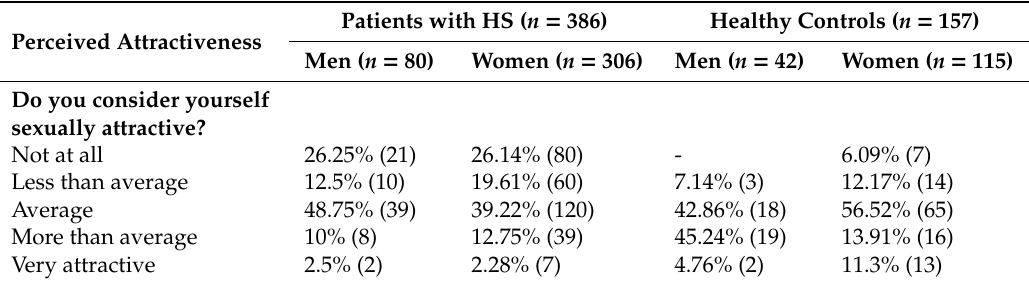
Table 3. Perceived attractiveness in patients with HS and healthy controls.